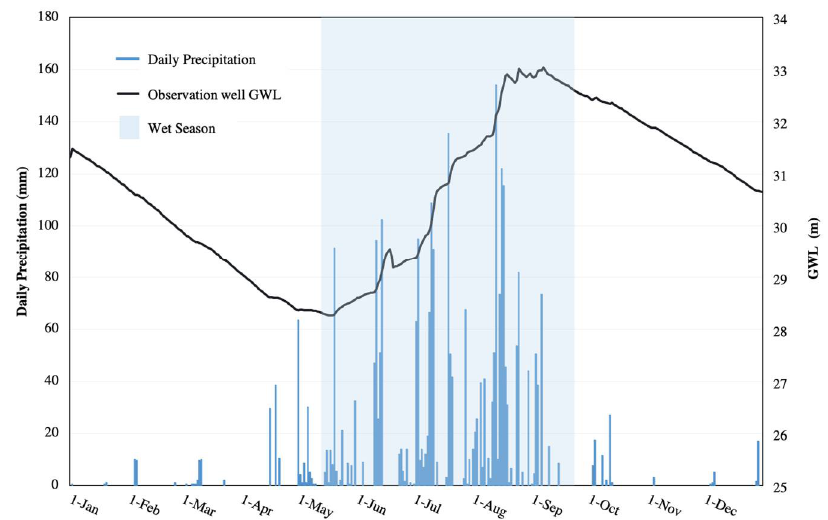
Figure 3. Taiwan Central Weather Bureau meteorological observatory daily precipitation record and GWL of PG observation well.